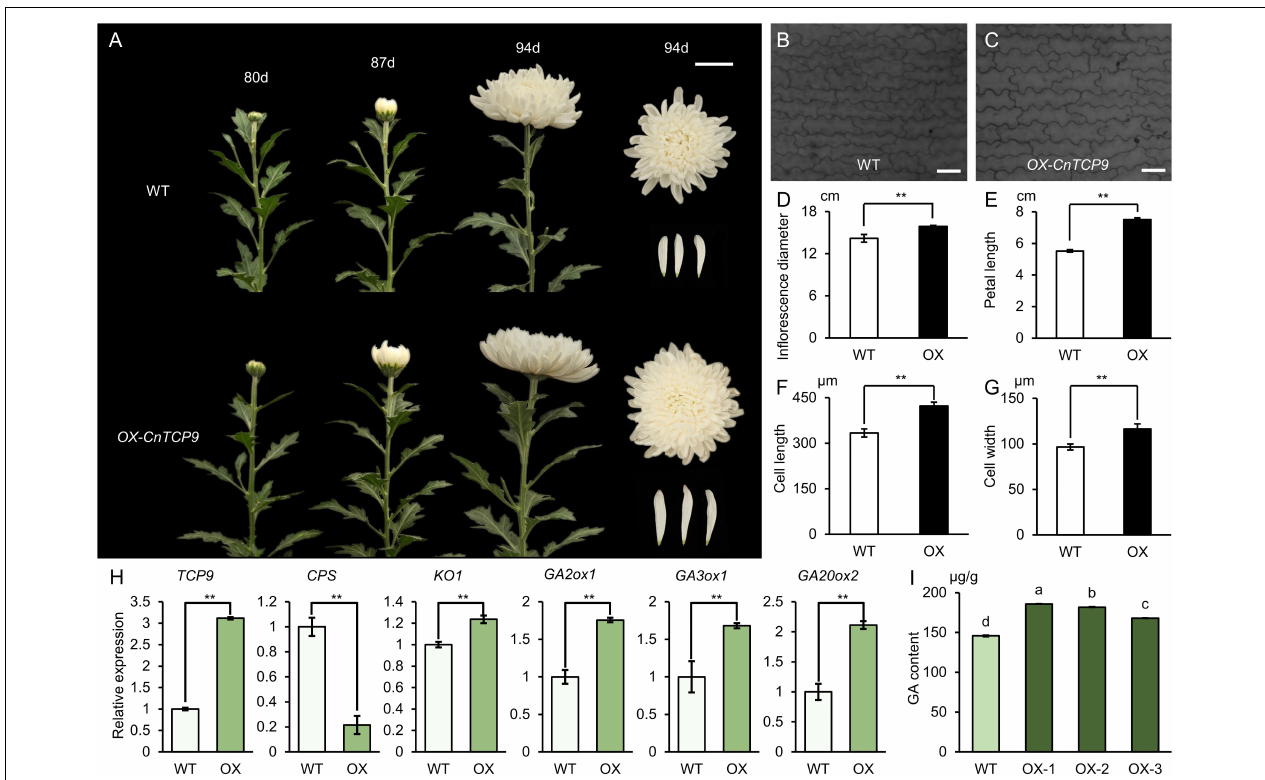
FIGURE 6 | Phenotype of overexpressing CnTCP9 in chrysanthemum. (A) Phenotypes of WT and OX-CnTCP9 transgenic plants at 80 d, 87 d, and 94 d after planting in the field; bar = 5 cm. (B,C) Cells of the middle regions of petals at blooming stage in WT and OX-CnTCP9 transgenic C. morifolium plants; bar = 170.0 µ m. (D) Inflorescence diameter of WT and OX-CnTCP9 transgenic plants. (E) Petal length of WT and OX-CnTCP9 transgenic plants. (F,G) Statistics of petal cell length and width of WT and OX (Overexpressing CnTCP9 C. morifolium ). Data are means ± SD . Two asterisks represent the values significantly different at p < 0.01 according to the t -test. (H) qRT-PCR analysis of GA pathway genes in WT and OX . Data are means ± SD . Two asterisks represent the values significantly different at p < 0.01 according to the t -test. (I) Statistics of GA3 content of WT and OX . Data are means ± SD . The different letters represent the values significantly different at p < 0.01 according to the one-way ANOVA